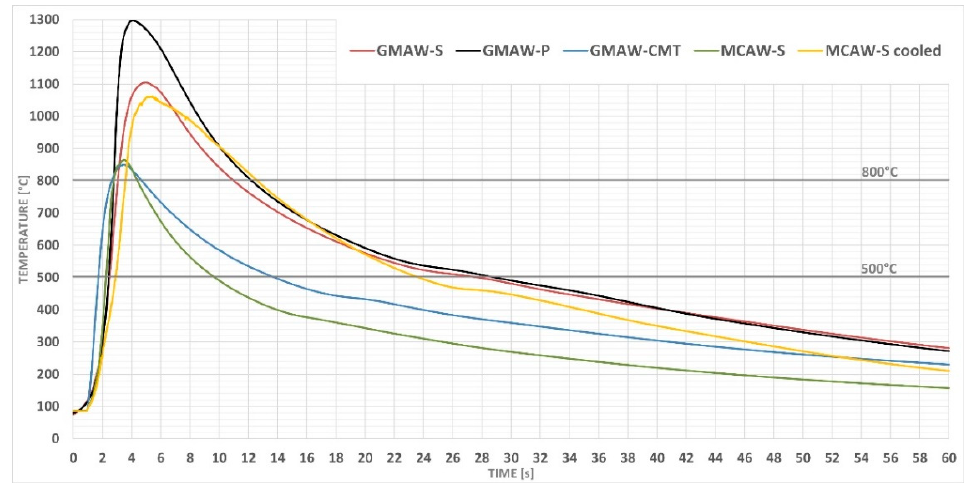
Figure 4. Thermal cycles of the assessed welded joints.